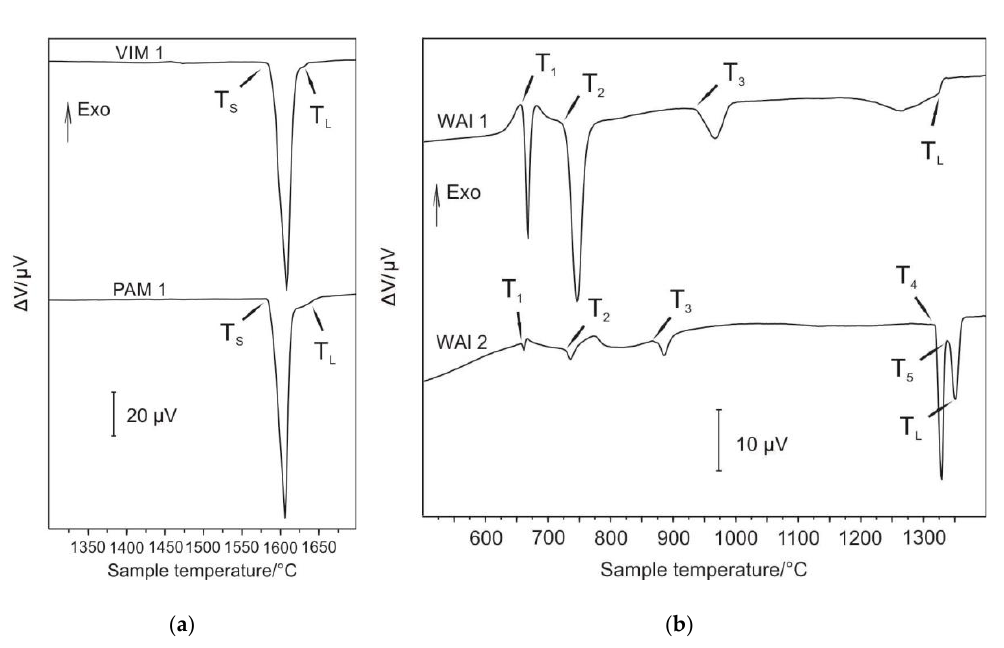
Figure 10. ( a ) Differential thermal analysis (DTA) curves for samples Nb – Al-VIM-1 and Nb – Al-PAM- Figure 10. ( a ) Di ff erential thermal analysis (DTA) curves for samples Nb–Al-VIM-1 and Nb–Al-PAM-1; 1; ( b ) DTA curves for samples W – Al-VIM-1 and W – Al-VIM-2. ( b ) DTA curves for samples W–Al-VIM-1 and W–Al-VIM-2. Table 3. Measured values of liquidus and solidus in Nb–Al-VIM-1 and Nb–Al-PAM-1 samples by DTA and detected values with using Thermo-Calc software (all results in ◦